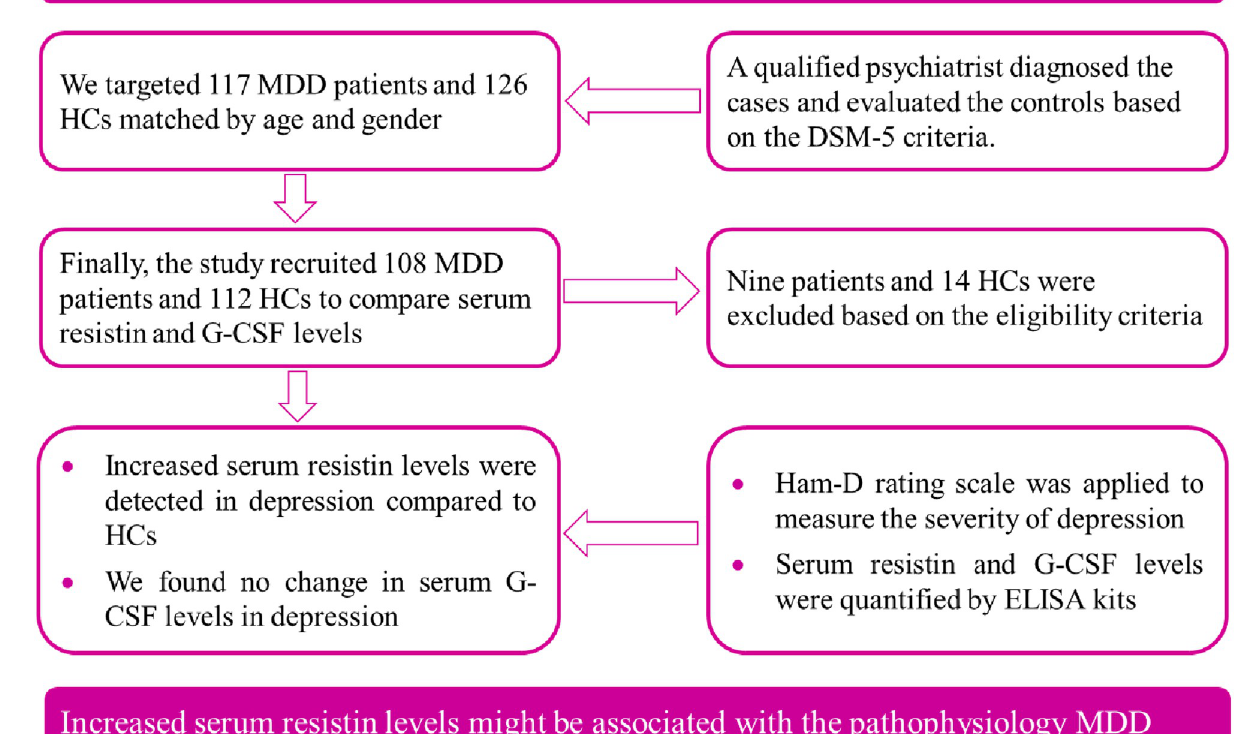
Fig 4. Summary of the study with procedures and